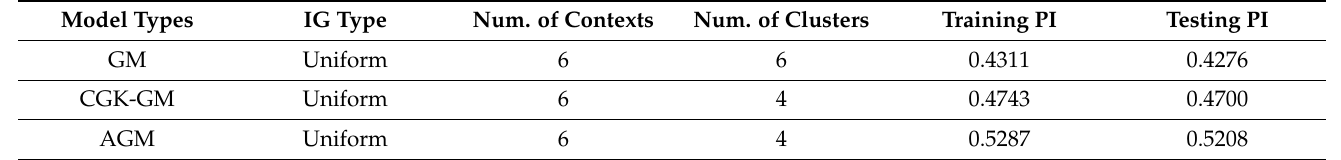
Table 7. Experimental Results of Predicting Concrete Compressive